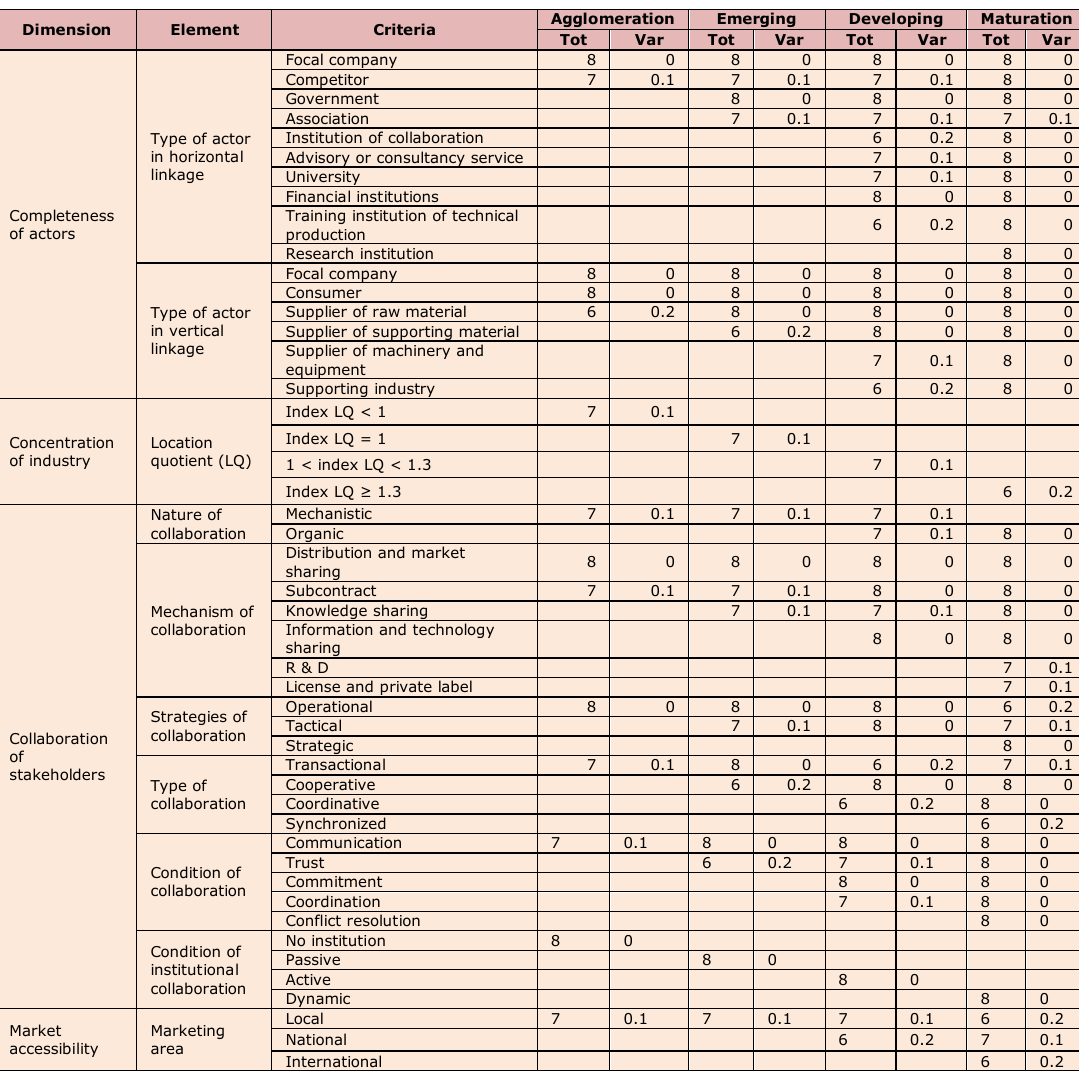
Table 6. Data Collection and Variance Calculation the Delphi Results in Round 3 At the third round, no additional information was sought from the experts, but rather we clarified the model and reached consensus. Consensus was proven